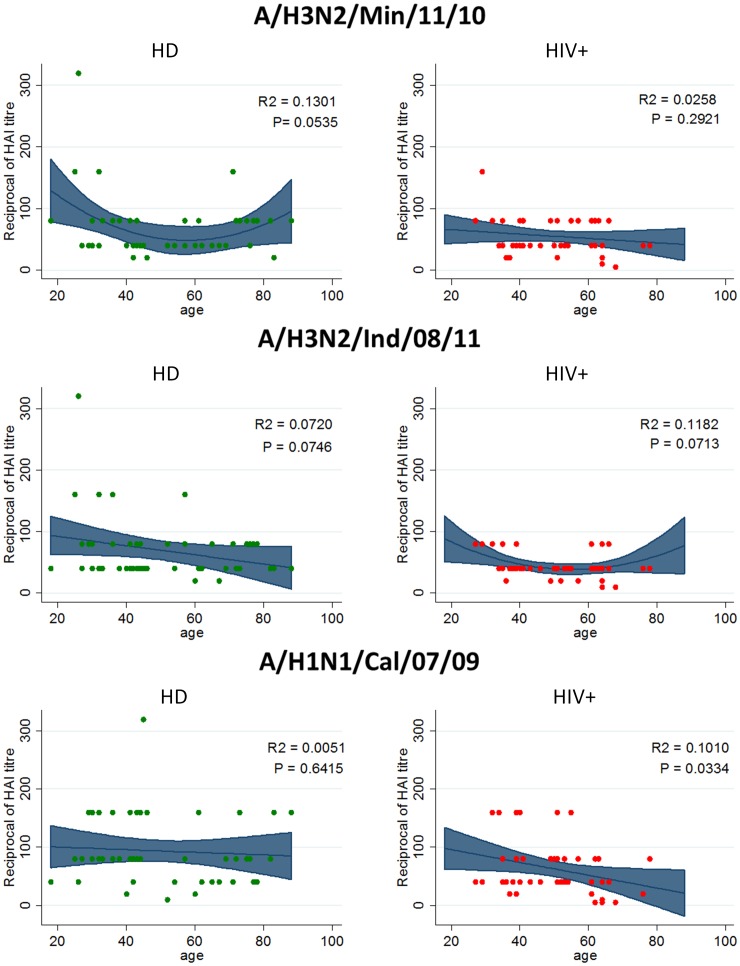
Association between age and humoral immune response to different influenza A virus strains.Age-related relationships of HAI titer against A/H3N2/Min/11/10, A/H3N2/Ind/08/11 and A/H1N1/Cal/07/09 in either HD (left panels) or HIV+ patients (right panels) was assessed by linear regression model. Departure from linear trend was assessed by model based likelihood ratio test (LTR) to assess the model including age as polynomial predictor.